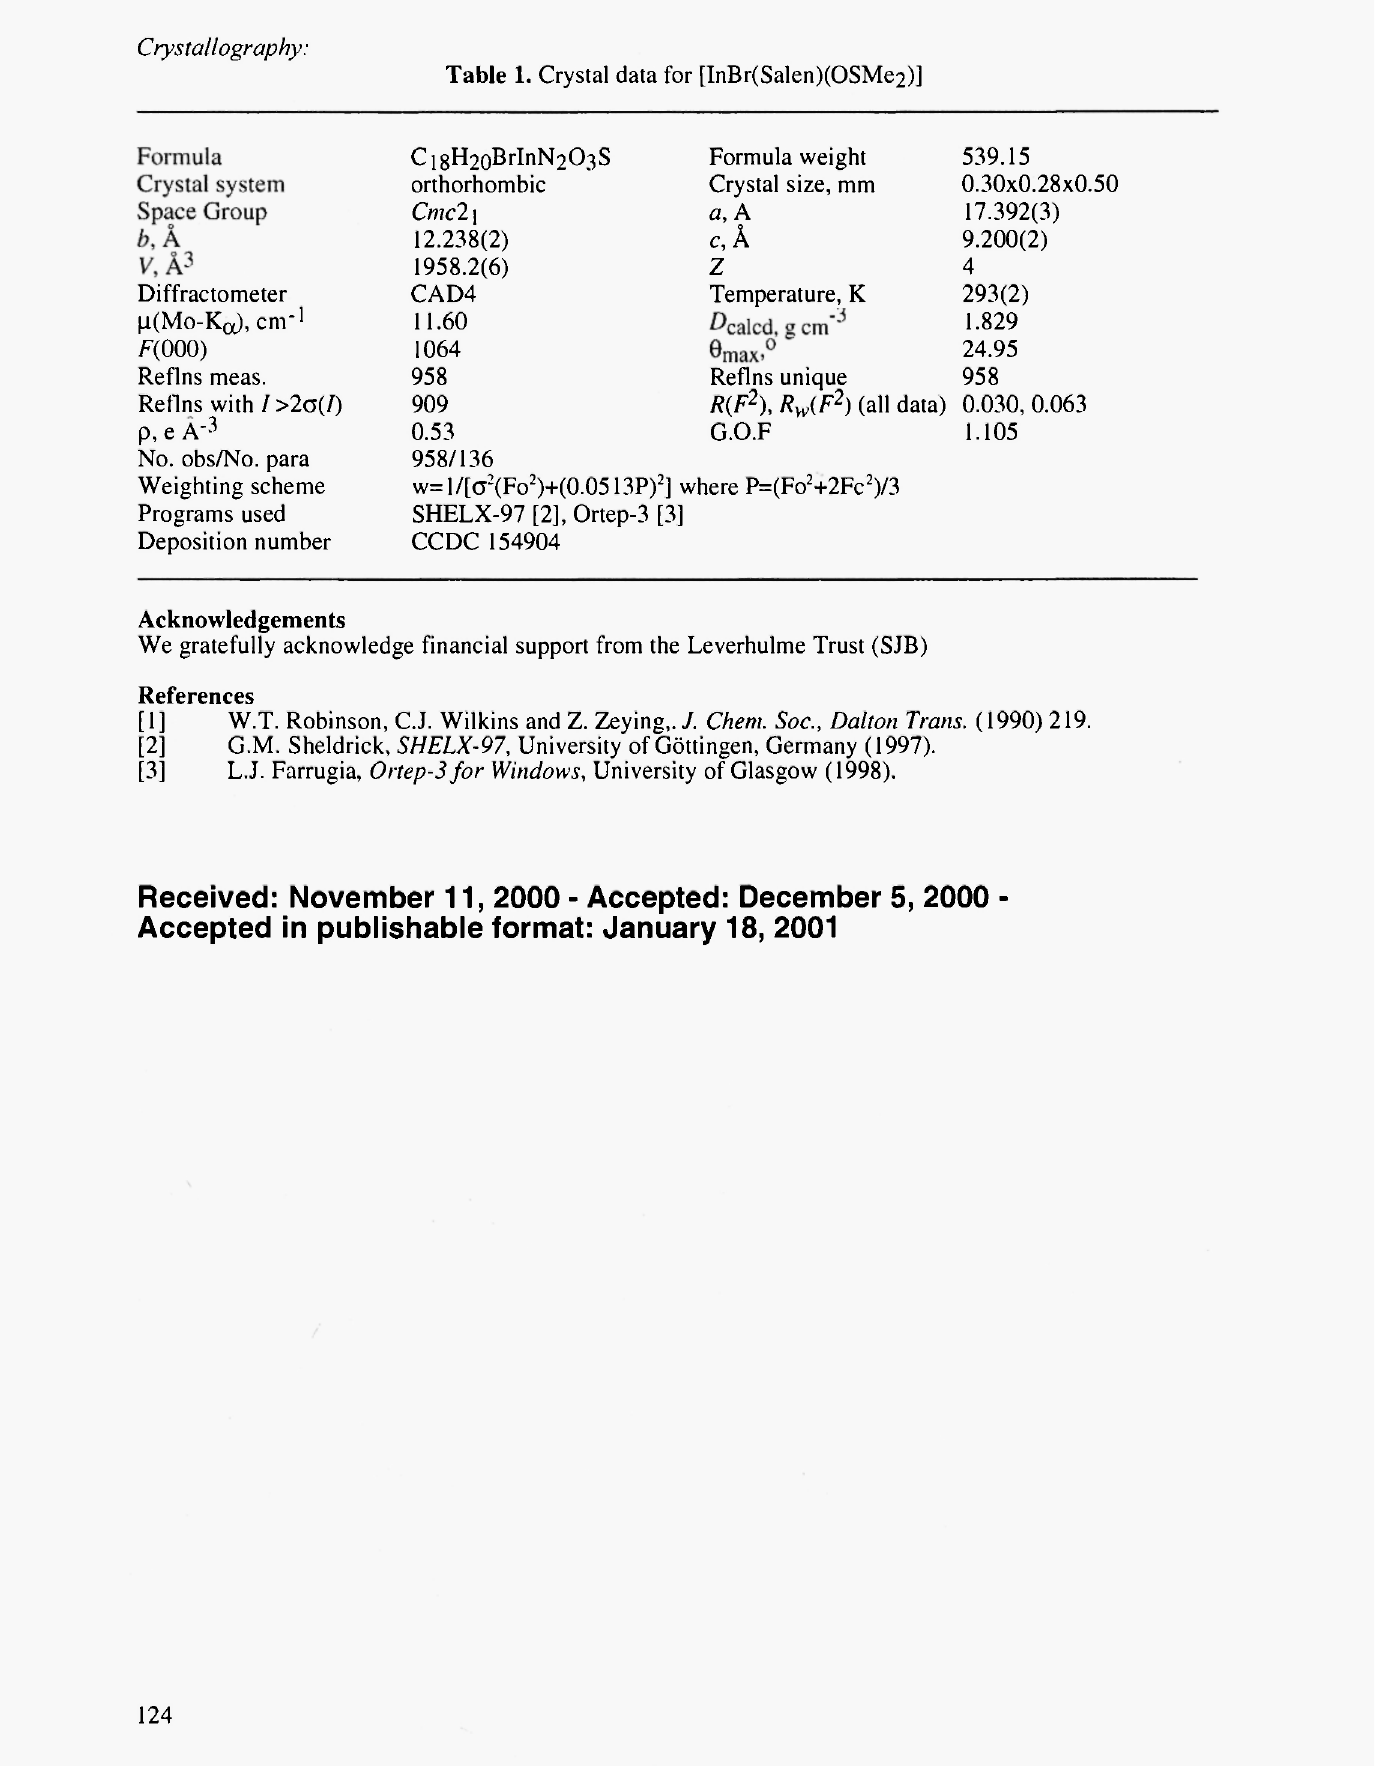
Table 1. Crystal data for [InBr(Salen